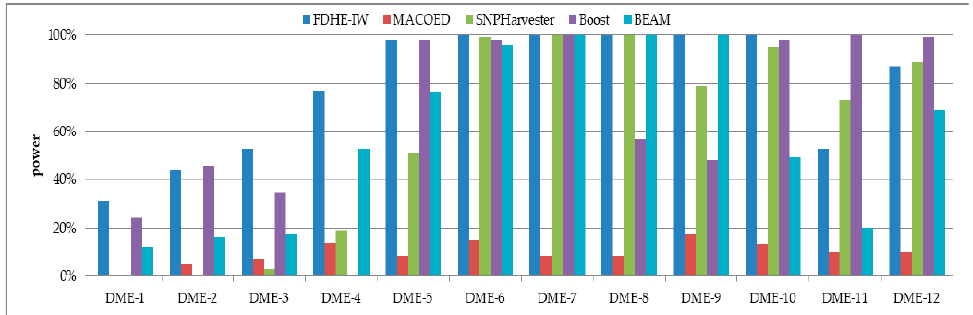
Figure 3. Detection powers of the five evaluated algorithms (1000 SNPs, 4000 sample size).